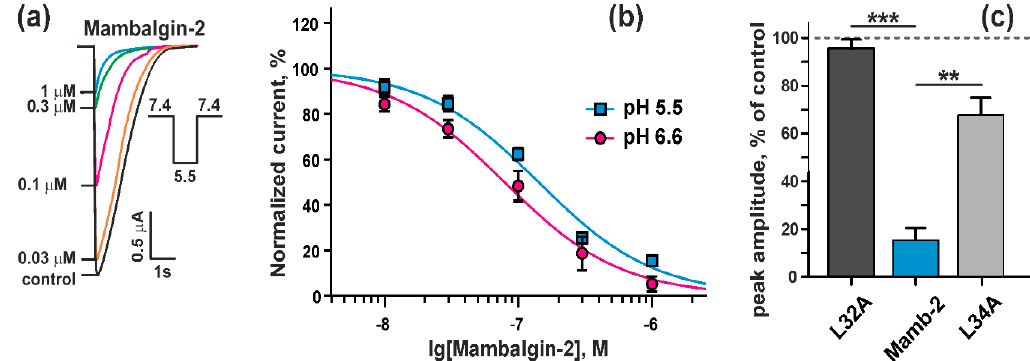
Figure 2. Effect of recombinant mambalgin-2 on rat ASIC1a expressed in Xenopus laevis oocytes: ( a ) Representative responses recorded in absence of mambalgin-2 (control) or presence of different mambalgin-2 concentrations, induced by buffer pH change from 7.4 to 5.5; ( b ) Dose–response inhibitory curves for mambalgin-2 at rat ASIC1a were fitted using Hill equation with IC 50 142 ± 12 nM and 79 ± 9 nM for pH 5.5 stimulus (n = 6) and pH 6.6 stimulus (n = 8), respectively. The Hill coefficient was assumed equal to 1.0. Data are presented as % of control (without mambalgin-2) ± SEM; ( c ) Comparison of the peak amplitude of the transient currents at ASIC1a at pH 5.5 in presence of 1 µ M mambalgin-2 and its variants with L32A and L34A substitutions. Data are presented as normalized peak current amplitude, % of control ± SEM (n = 6). Control level (100%) is shown by dashed line. ** ( p < 0.01) and *** ( p < 0.0001) indicate significant di ff erence between data groups according to One-way ANOVA followed by Dunnett’s test.